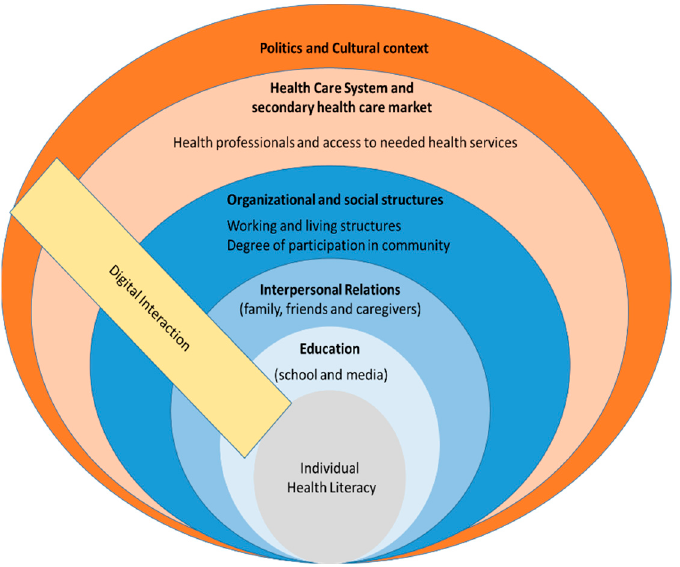
Figure 1. Dimensions of social context and health literacy in people with intellectual disabilities. Table 1. Levels of social context in people with intellectual disabilities.